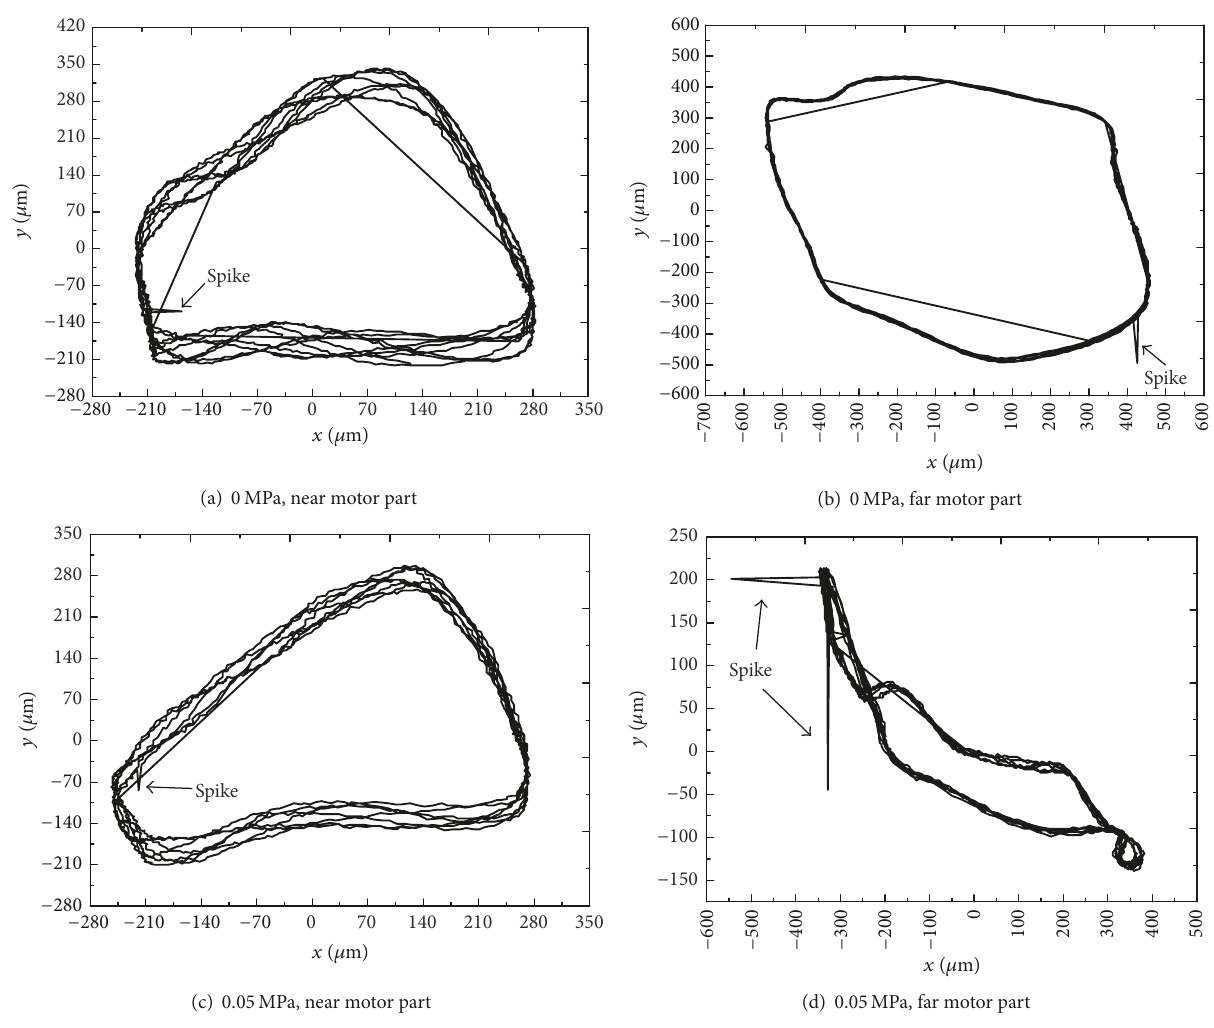
Figure 7: Shaft orbit in 400